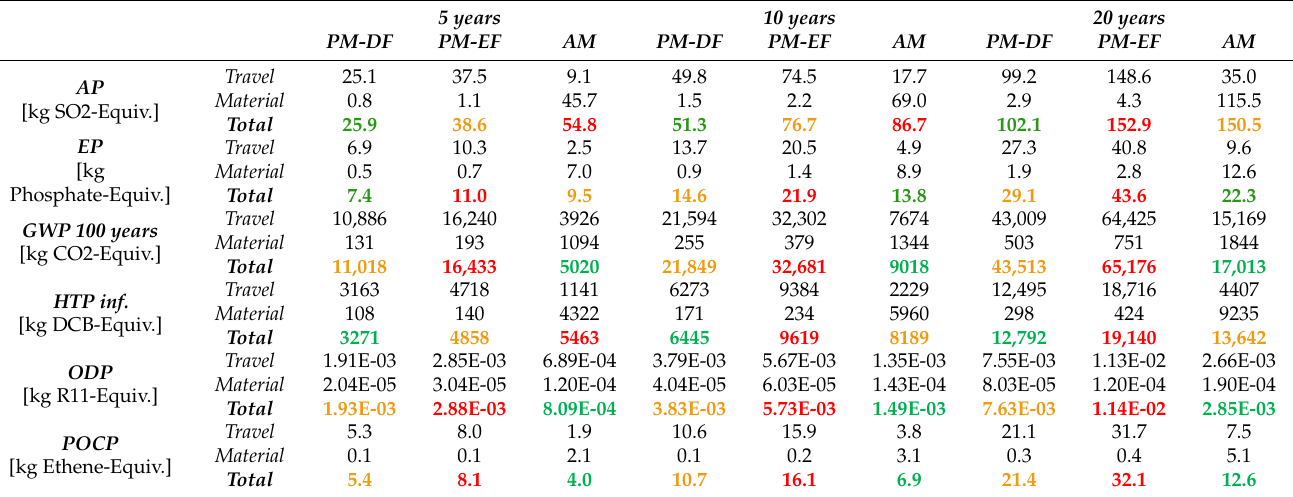
Table 7. Results of LCIA for a monitoring site at a distance of 400 km. PM, Passive monitoring; AM, active monitoring; DF, deciduous forest; EF, evergreen Mediterranean forest. Impact categories: AP= Acidification Potential; EP= Eutrophication Potential; GWP= Global Warming Potential; HTP= Human Toxicity Potential; ODP= Ozone layer Depletion Potential; POCP= Petrochemical Ozone Creation Potential. For each time scenario (5, 10 and 20 years from installation), total emissions are reported in different colours that highlight the best (green), worst (red) and intermediate